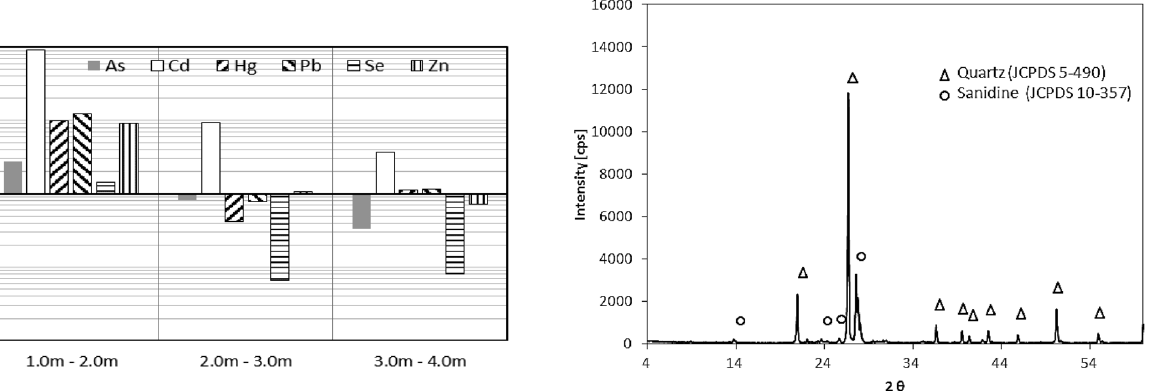
Fig. 2 XRD analysis of the sampled